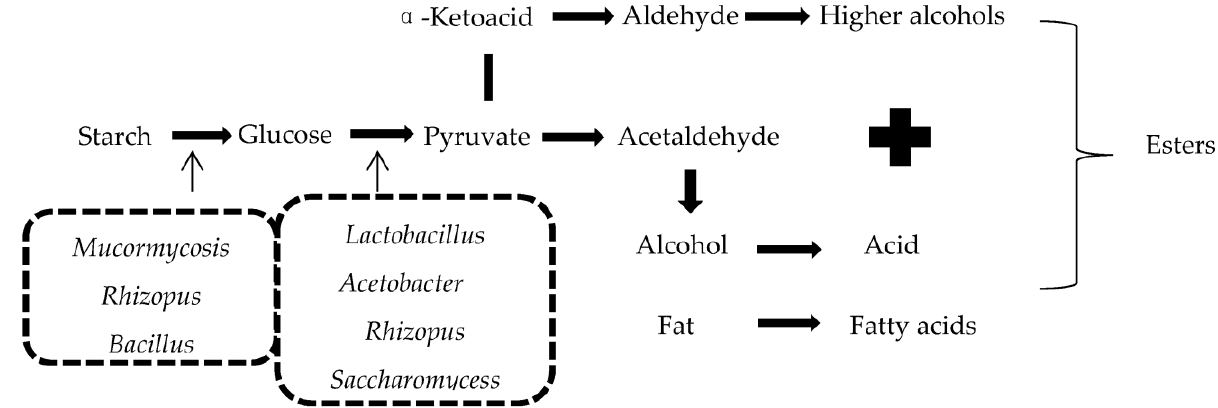
Figure 2. Key — transformations of glucose and the formation of esters. Figure 2. Key—transformations of glucose and the formation of